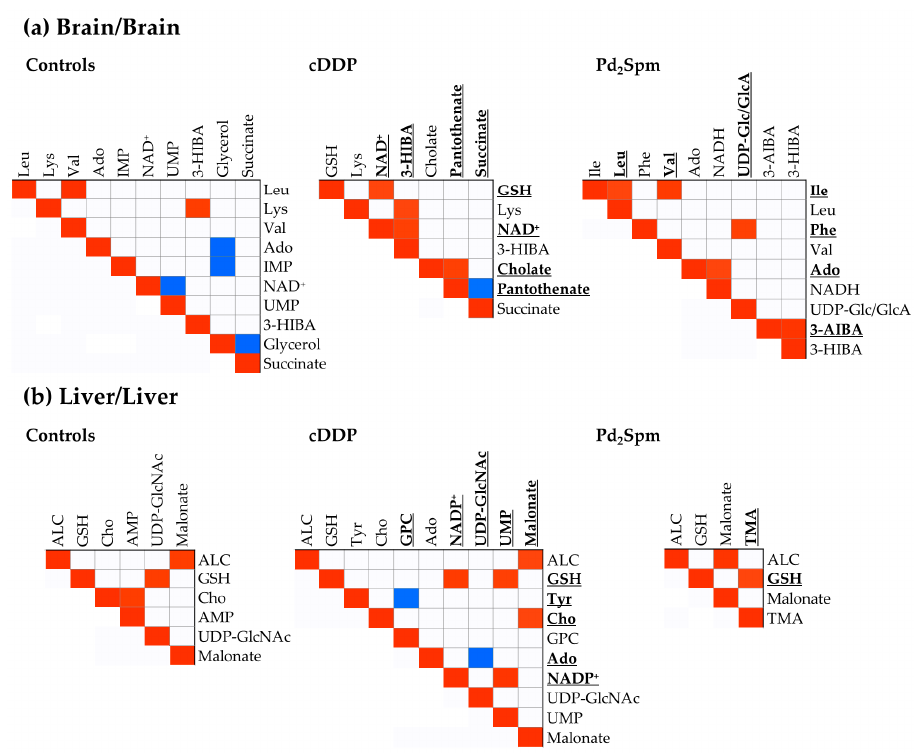
Figure 5. Spearman correlations between the significant metabolic variations within each tissue, namely ( a ) brain and ( b ) liver, for controls (left), the cDDP-treated group (middle), and the Pd 2 Spm-treated group (right), considering an absolute correlation coefficient of 0.90. All p -values of correlations are comprehended between 0.05 and 0.001 and are then considered statistically relevant. Bold and underlined metabolites represent new correlations regarding those found in controls (left). Abbreviations: ALC, O -acetylcarnitine. Other abbreviations as defined in Figures 1 and 4.